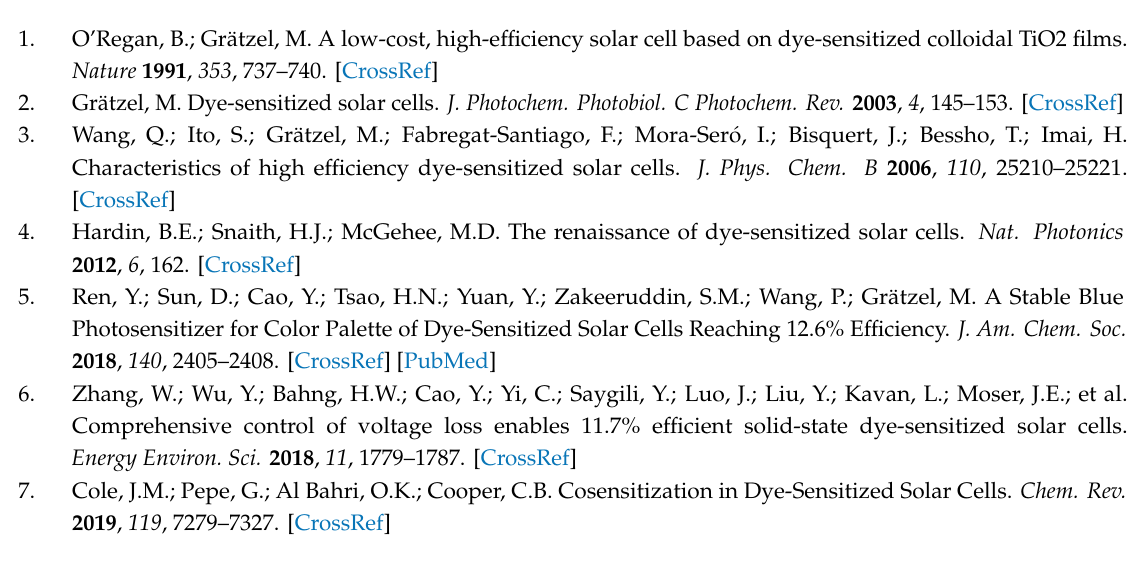
Figure 6. Schematic depicting the expected scattering effects in the DSSC device fabricated using the S3 sample.